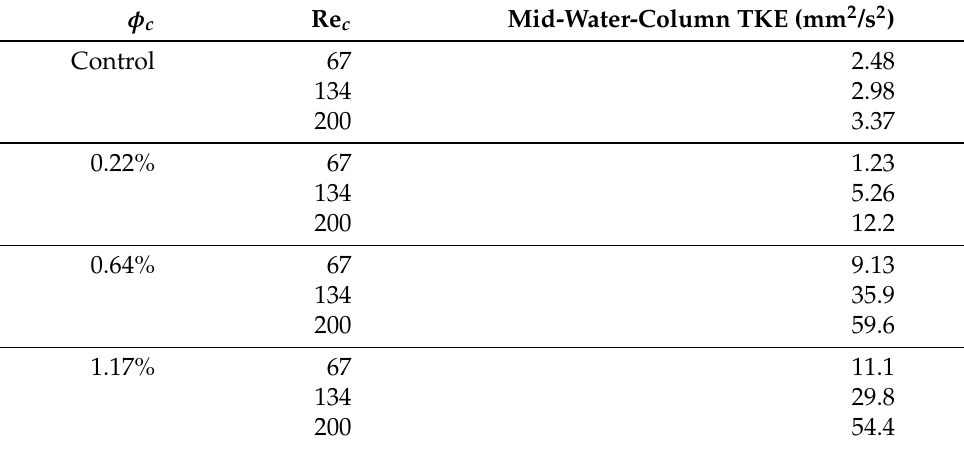
Table 2. Turbulence kinetic energy (TKE) for all collector solid volume fraction ( φ c ) and Re c treat- ments, including the control (zero-collector) treatments for